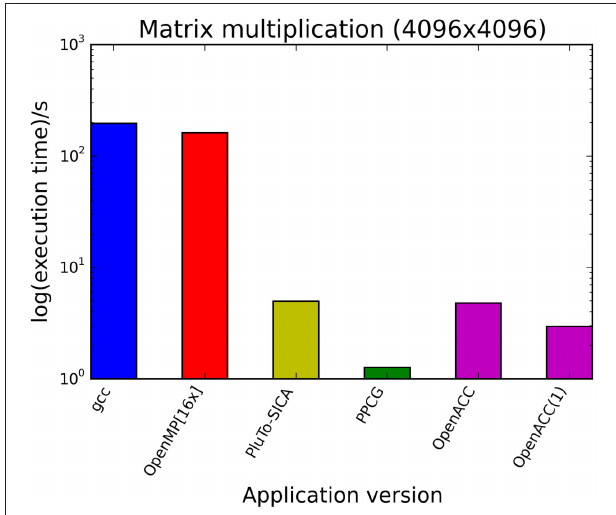
FIGURE 7 | Comparison of different automatic optimization techniques for matrix multiplication. Two 4096 × 4096 matrices are multiplied. OpenACC corresponds to the time needed only for computation neglecting the time needed for driver initialization. OpenACC (1) is a version introducing a temporary variable (see Supplementary Material, listing 4).